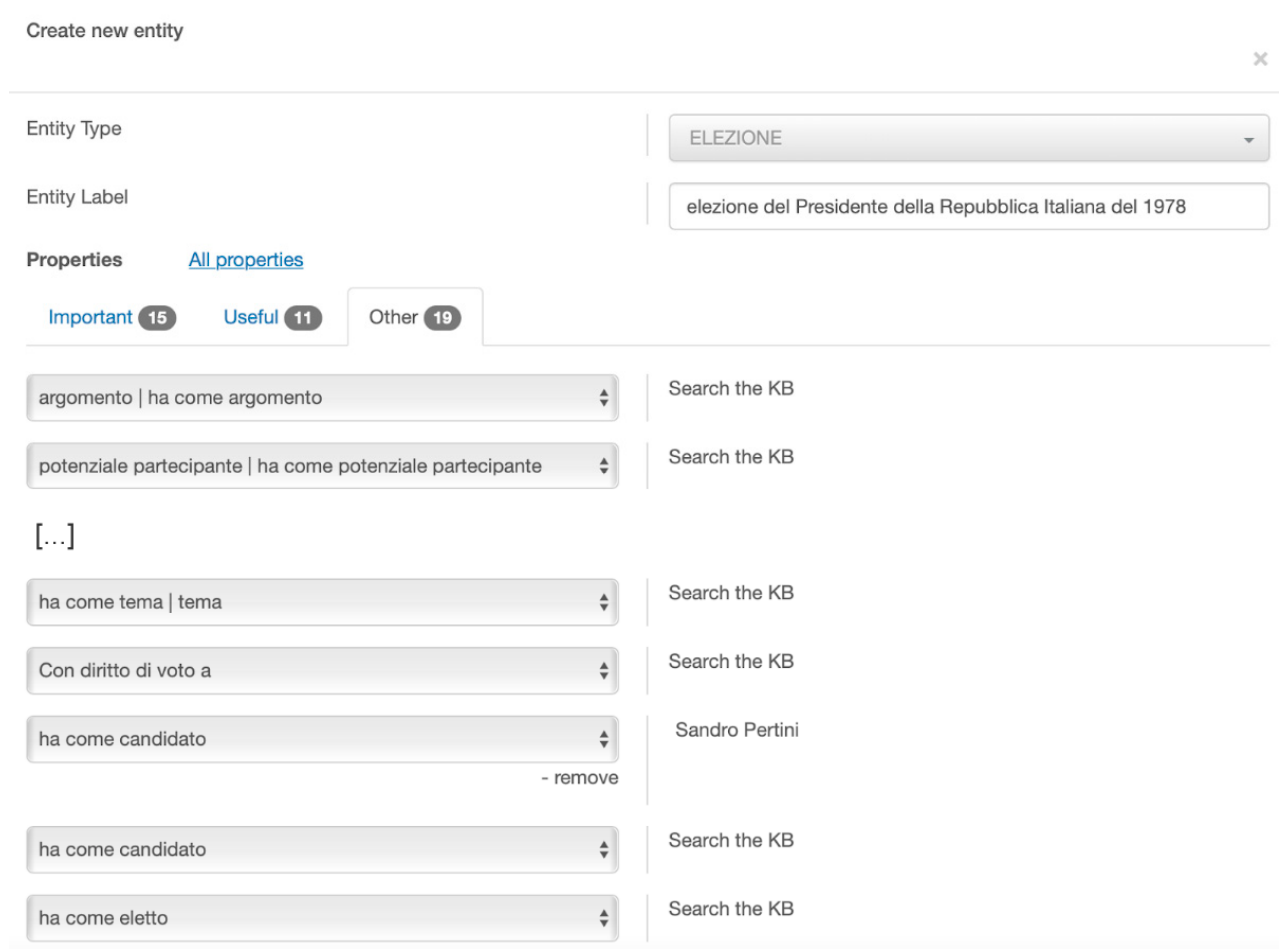
Figure 14. Part of the form related to the characterization of the 1978 Italian presidential election, with Sandro Pertini as candidate.